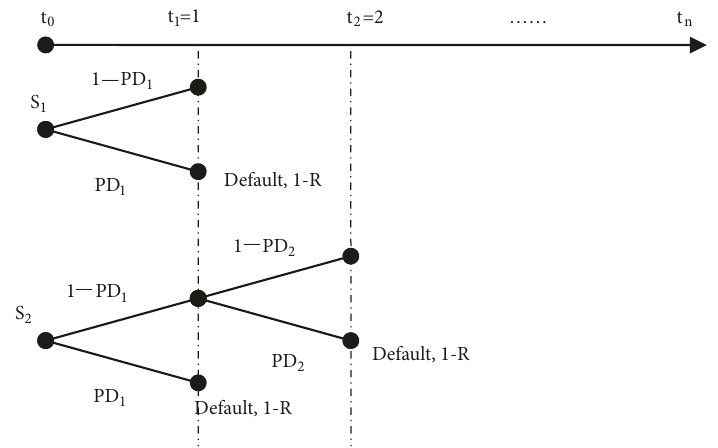
Figure 3: Binary tree-CDS pricing solution (one-time payment of premiums).